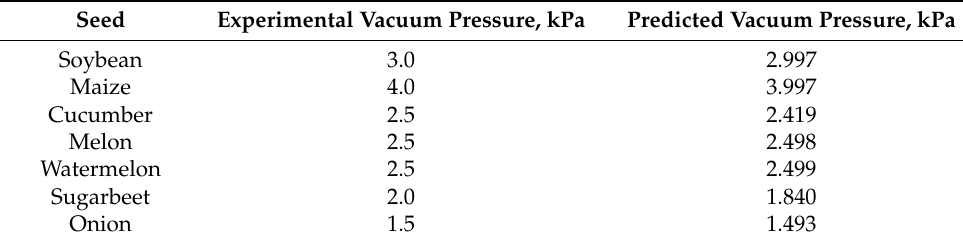
Table 5. Experimental and predicted (using artificial neural network) optimum vacuum pressure